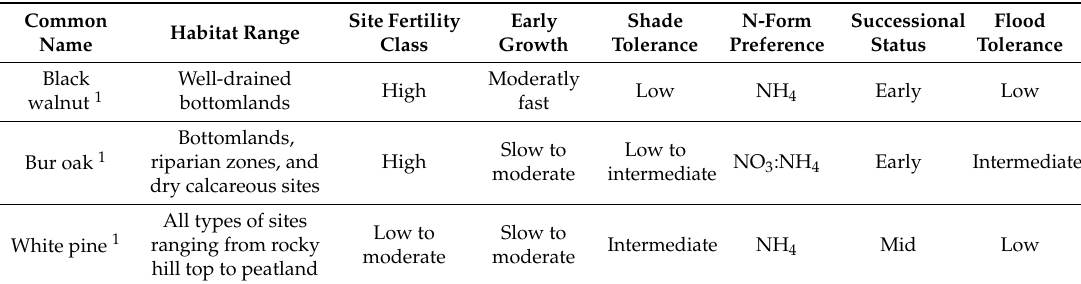
Table 1. Ecological characteristics of the studied